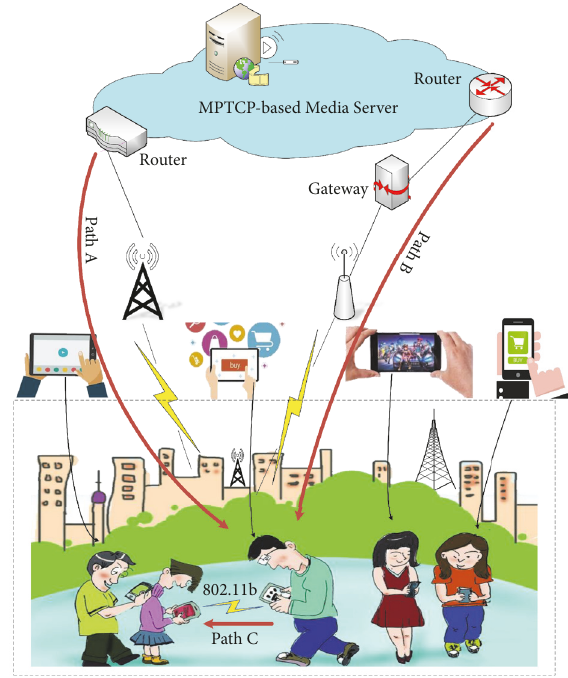
Figure 1: MPTCP-based multimedia multipath transmission in wireless